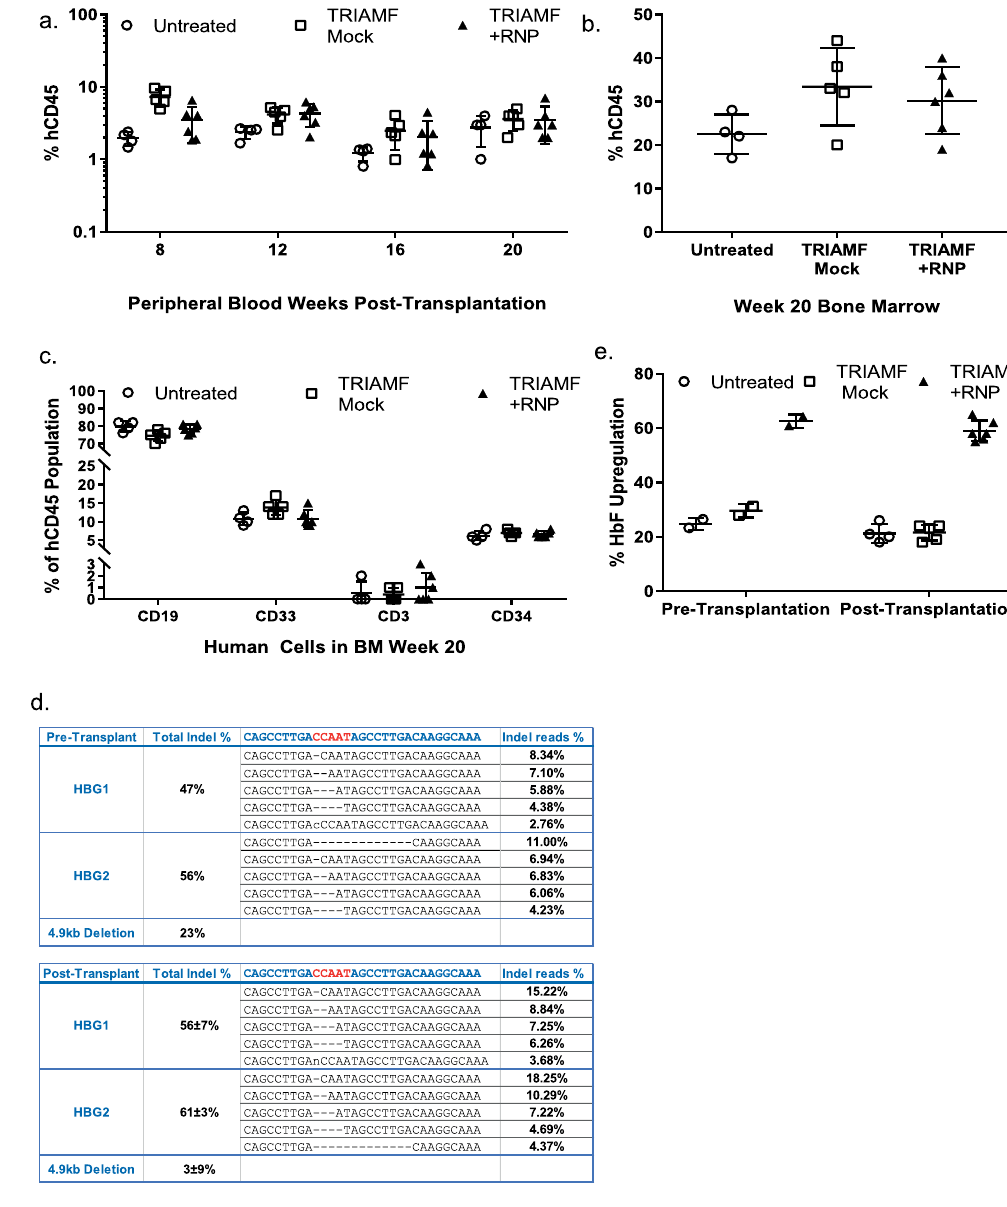
Figure 3. Preservation of engraftment competency of HSPCs post TRIAMF treatment. 7 × 10 5 viable HSPCs (from the same donor as used in Fig. 2) 1-day post treatment were transplanted into each sub-lethally irradiated recipient mouse via tail vein injection. ( a ) Human CD45 + chimerism of untreated (n = 4 mice), mock treated (TRIAMF Mock, n = 5 mice), and g1-RNP edited (TRIAMF + RNP, n = 6 mice) in the peripheral blood 8, 12, 16, and 20 weeks post-transplantation. ( b ) Human CD45 + chimerism in mouse bone marrow 20 weeks post- transplantation. ( c ) Lineage distribution of human CD45 + cells isolated from mouse bone marrow 20 weeks post- transplantation. ( d ) Two aliquots of HSPCs from the same donor were processed by TRIAMF. One aliquot of cells was harvested 48 hours after treatment (Pre-Transplant, n = 1) and the other aliquot of cells were engrafted into NGS mice from which hCD45 + cells were harvested from mouse bone marrow 20 weeks after transplantation (Post-Transplant, n = 6 mice). The total mutation rate and top 5 most frequent indel alleles as a percentage of total NGS reads at HBG1 and HBG2 sites were shown. For the Post-Transplant group, indel patterns are the mean of all the mice. ( e ) Comparison of HbF + immunostaining of CD235a + /CD71 − /low cells after erythroid differentiation of HSPCs 48 hours post treatment (n = 2, technical duplicate) and hCD45 + /CD34 + HSPCs harvested from mouse bone marrow 20 weeks post transplantation (n = 4–6